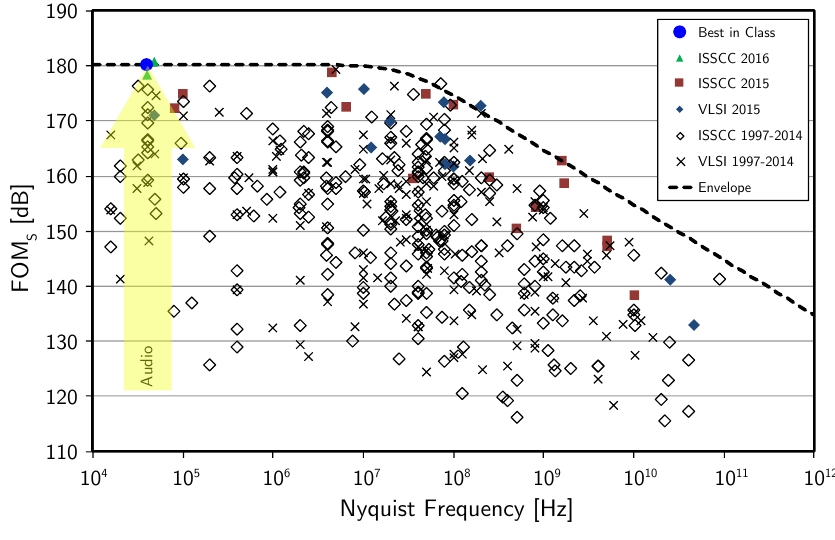
Figure 6. ADC state-of-the-art based on FoM S from